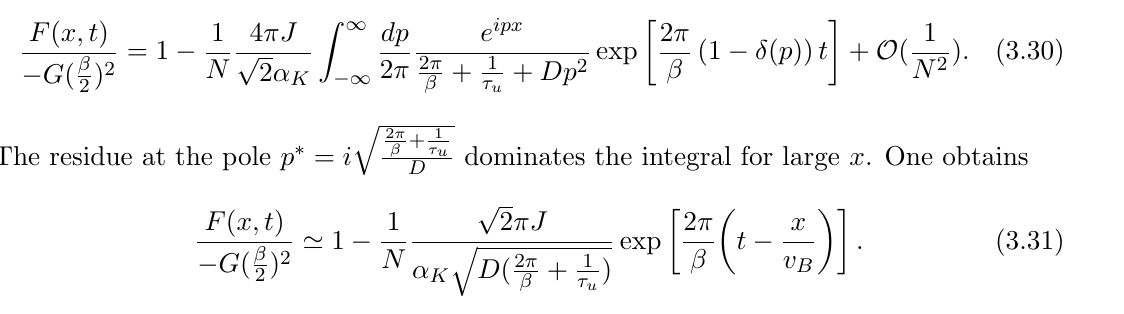
F ( x; t ) is given by Fourier transforming eq. (3.28) back into real space